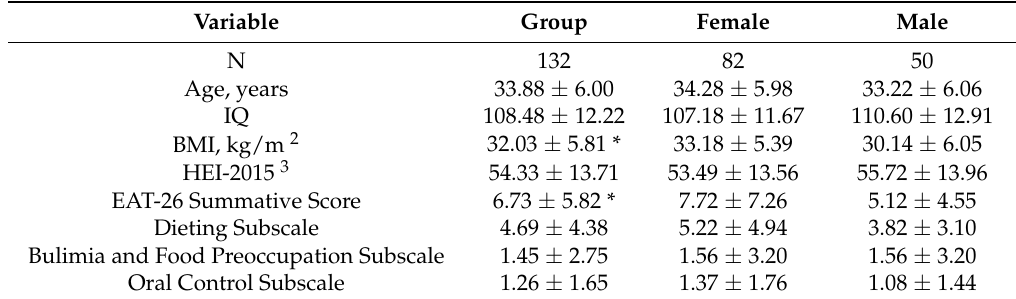
Table 1. Demographic characteristics, weight status, and EAT-26 variables 1